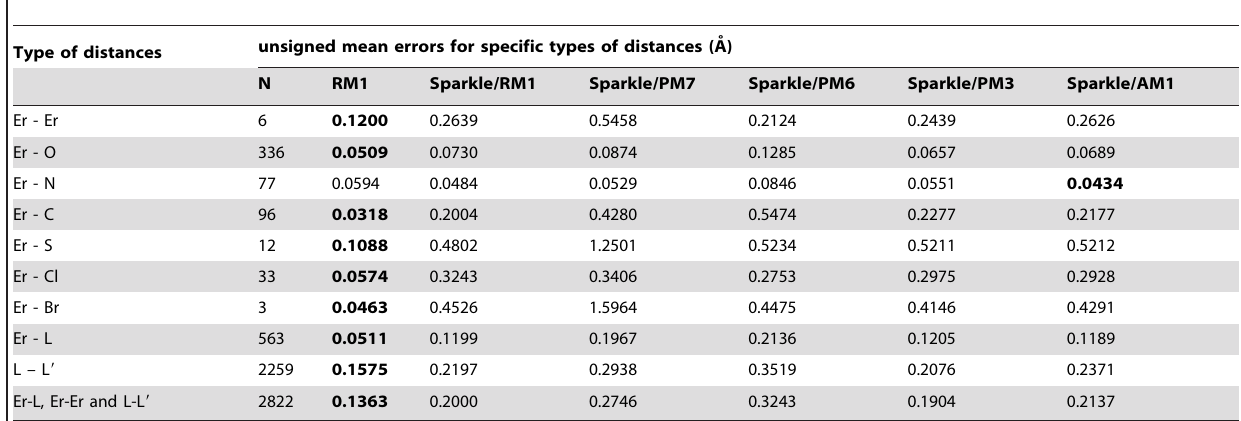
Table 9. RM1, Sparkle/RM1, Sparkle/PM7, Sparkle/PM6, Sparkle/PM3, and Sparkle/AM1 unsigned mean errors for specific types of distances for erbium complexes.